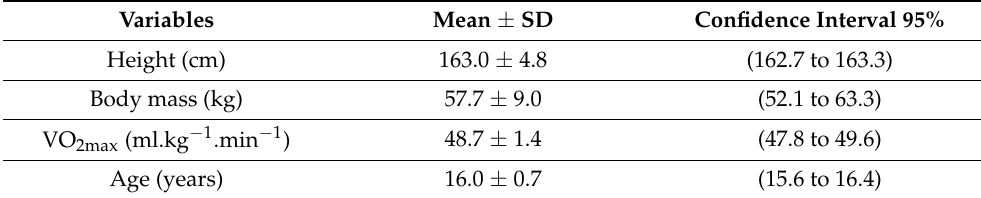
Table 1. Descriptive characteristics of the subjects.